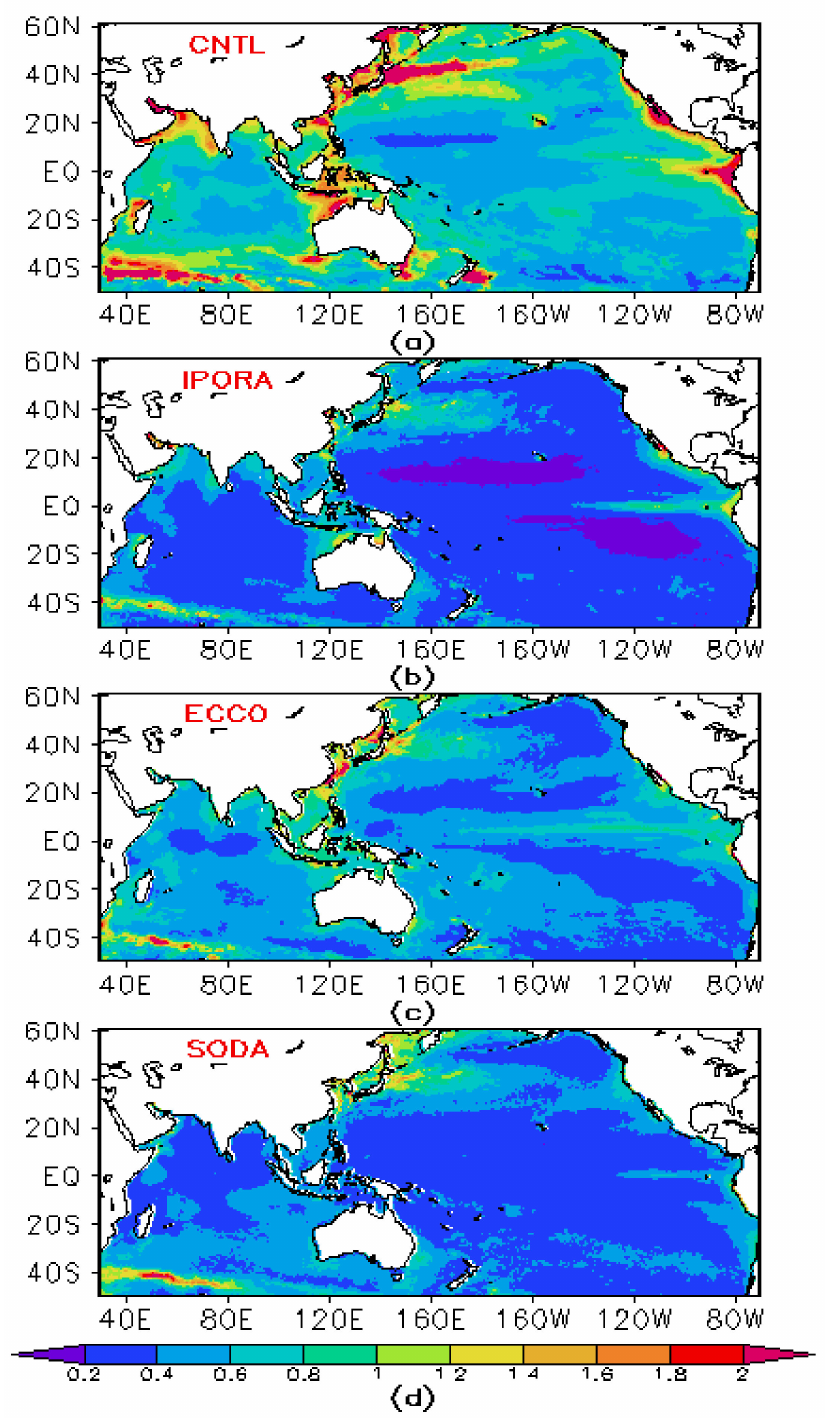
Figure 2. RMSEs of SST (units: ◦ C) in the model domain over the period of 1993–2020 from ( a ) CNTL, ( b ) IPORA, ( c ) ECCO, and ( d )